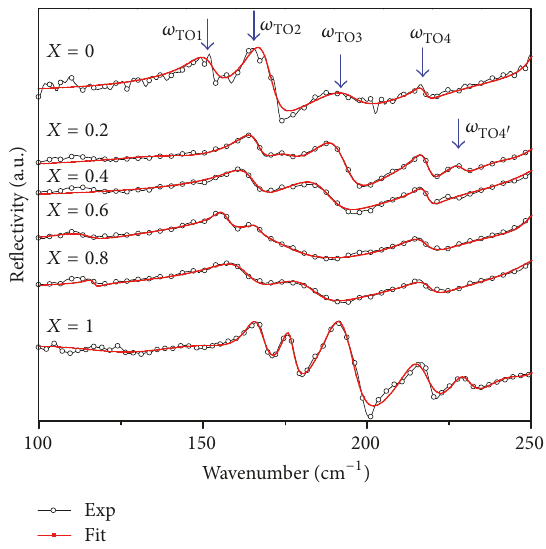
Figure 4: Detailed view of the low frequency ( < 250 cm −1 ) for Gd 1−𝑥 Y 𝑥 Mn 2 O 5 ( 𝑥 = 0 , 0.2, 0.4, 0.6, 0.8, and 1). The black open circle shows the experimental curve and the red line shows the fitted data. Arrows shows the mode evolution with 𝑥 and the spectra are vertically shifted for